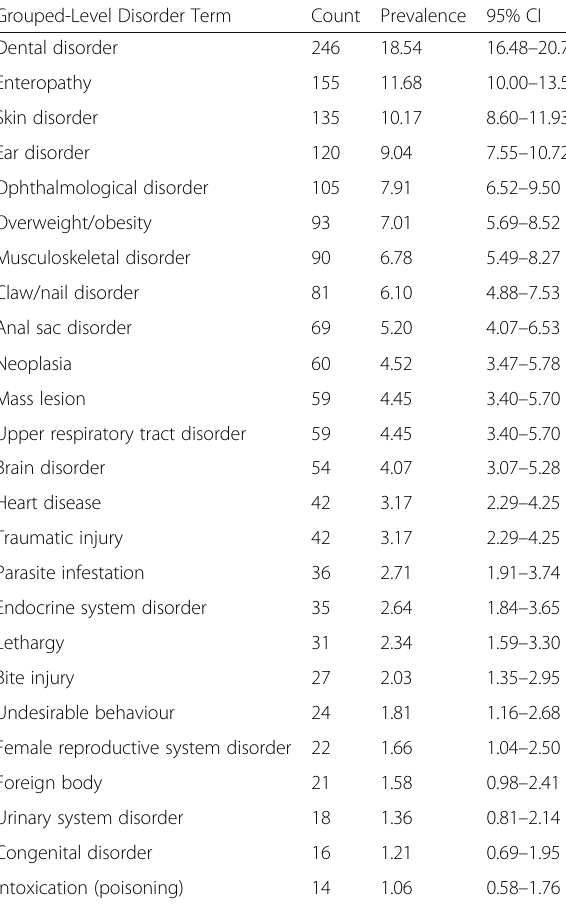
Table 3 Prevalence of the 25 most common disorder groups